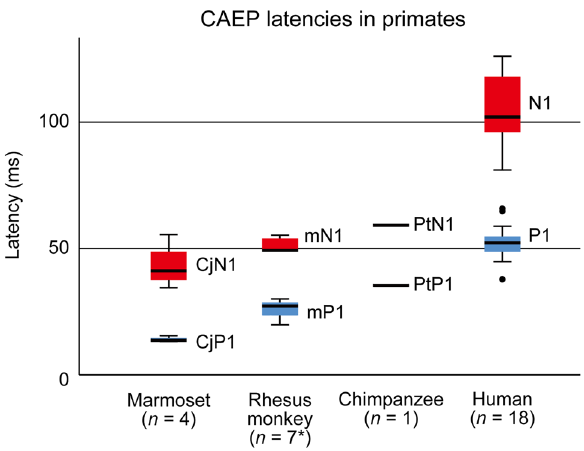
Figure 2. Box plot of the latencies of P1/N1 homologs in the four primate species. The thick horizontal line indicates the median, and the top and bottom box lines show the first and third quartiles. The whiskers show the maximum and minimum values, excluding outliers (circles) that were at least 1.5 box length from the median. Numbers in parentheses below the species names indicate the number of subjects ( n ). *Two rhesus monkeys were excluded for the evaluation of mN1, as the peak was not clearly identified in the individual CAEP waveforms. The mean ± standard deviation of the peak latencies was as follows: 14 ± 1 (CjP), 26 ± 4 (mP1), 36 ± 3 (PtP1), and 53 ± 7 (P1) for the P1 homologs; 43 ± 9 (CjN1), 51 ± 3 (mN1), 59 ± 3 (PtN1), and 104 ± 15 (N1) for the N1 homologs. The standard deviations were calculated over subjects in the common marmosets, rhesus monkeys, and humans, and over experimental conditions and sessions in the